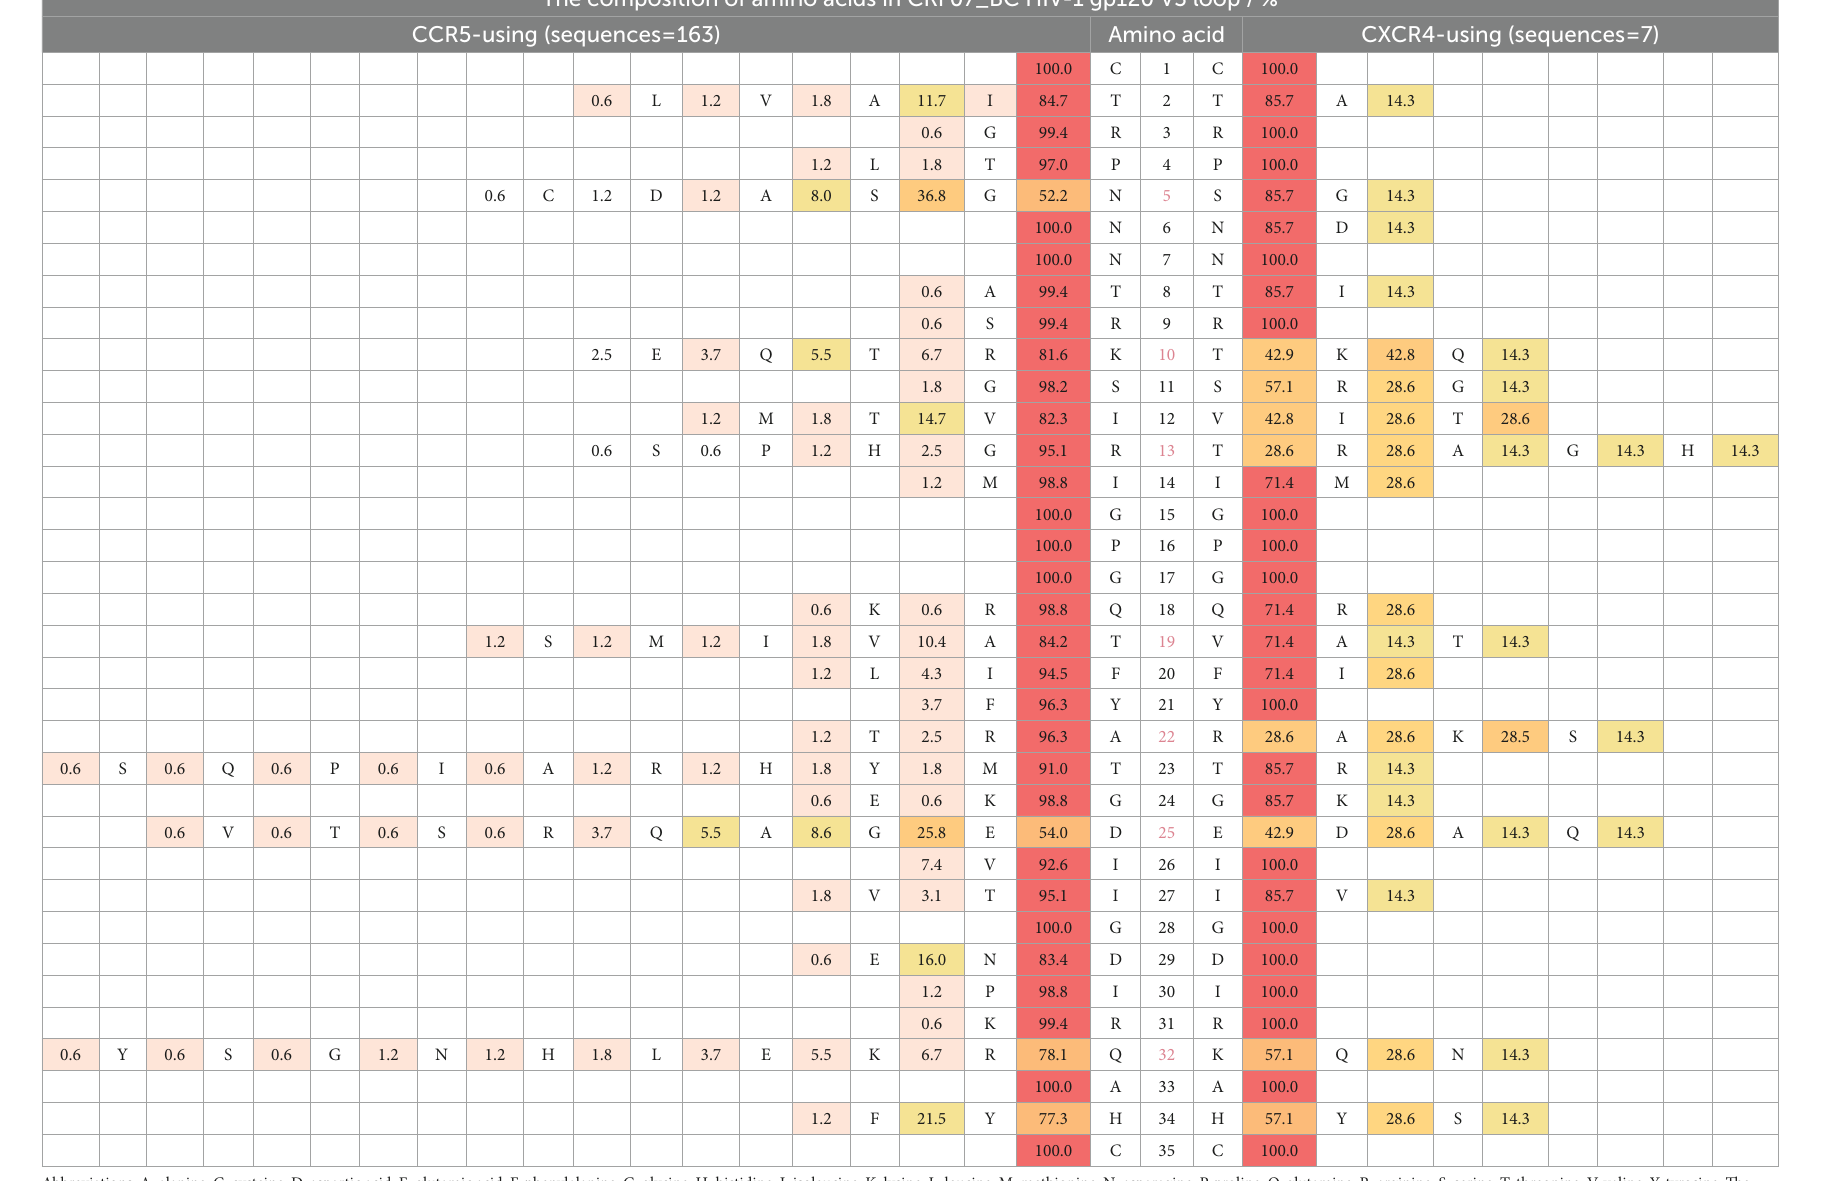
TABLE 4 The composition of amino acids in CRF07_BC HIV-1 gp120 V3